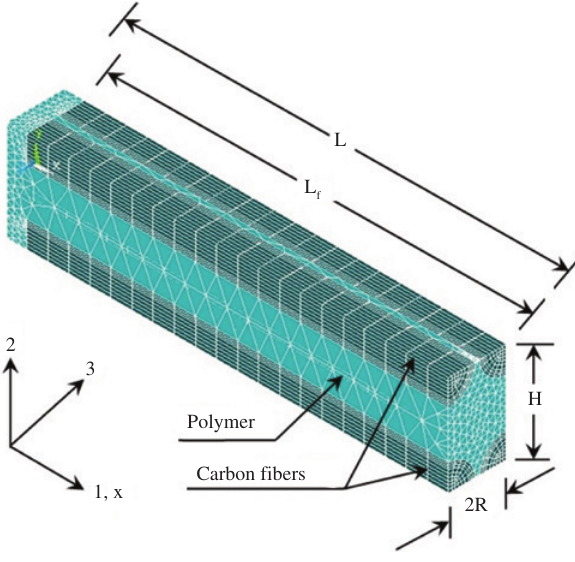
Figure 5: Three-dimensional FE mesh of the three-phase RVE.